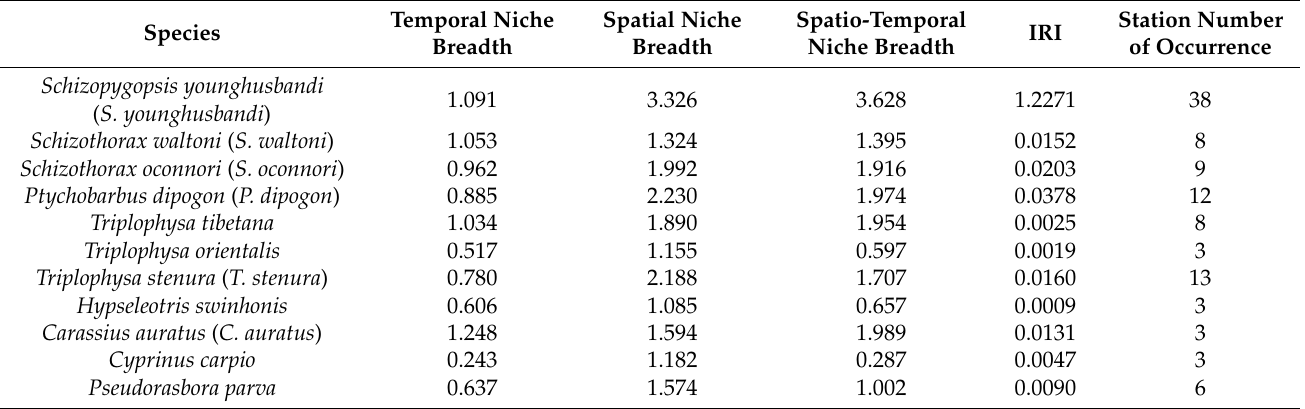
Table 1. Niche breadth, IRI and Station number of major species in the Lhasa